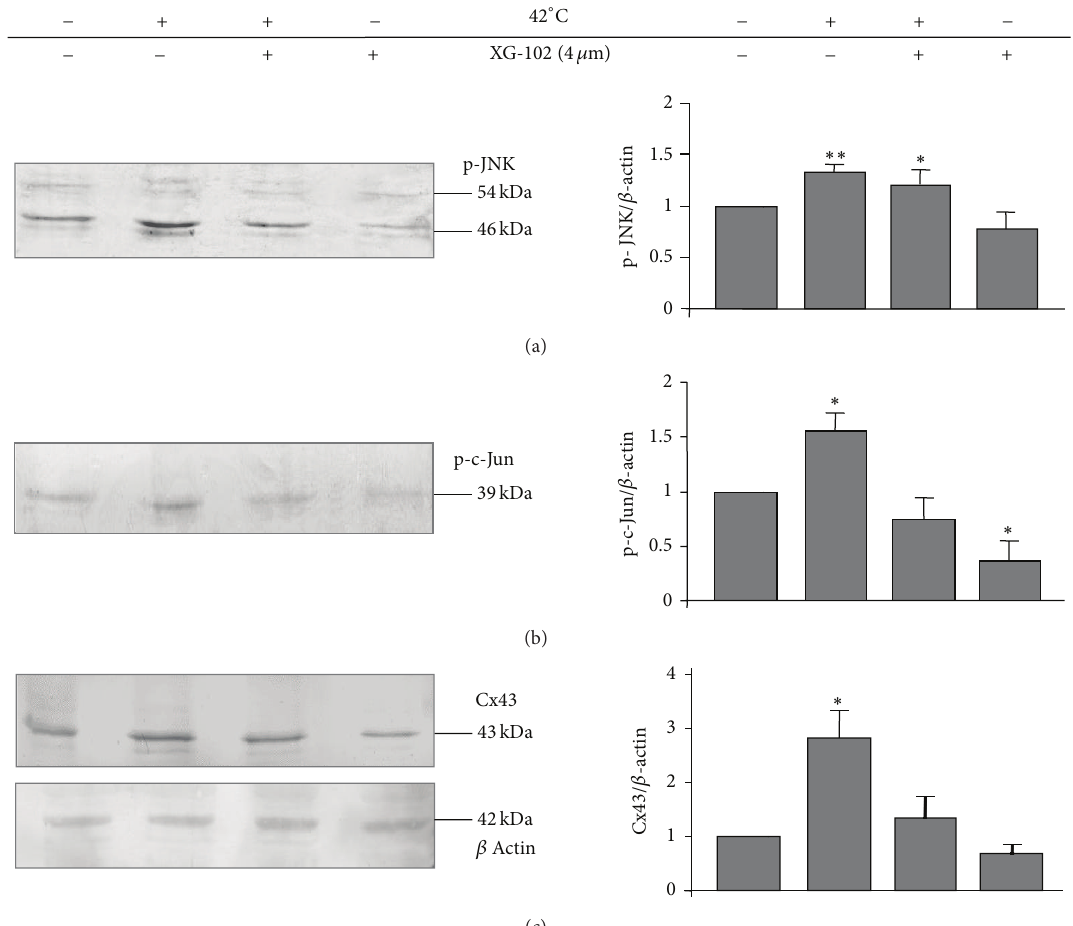
Figure 3: Effect of hyperthermia on the total expression of p-JNK (a), p-c-Jun (b), and endogenous Cx43 protein (c) in SkMs. 𝑛 = 3 in each set of experiments; ∗ = 𝑃 < 0.05 ; ∗∗ = 𝑃 < 0.01 , Student’s 𝑡